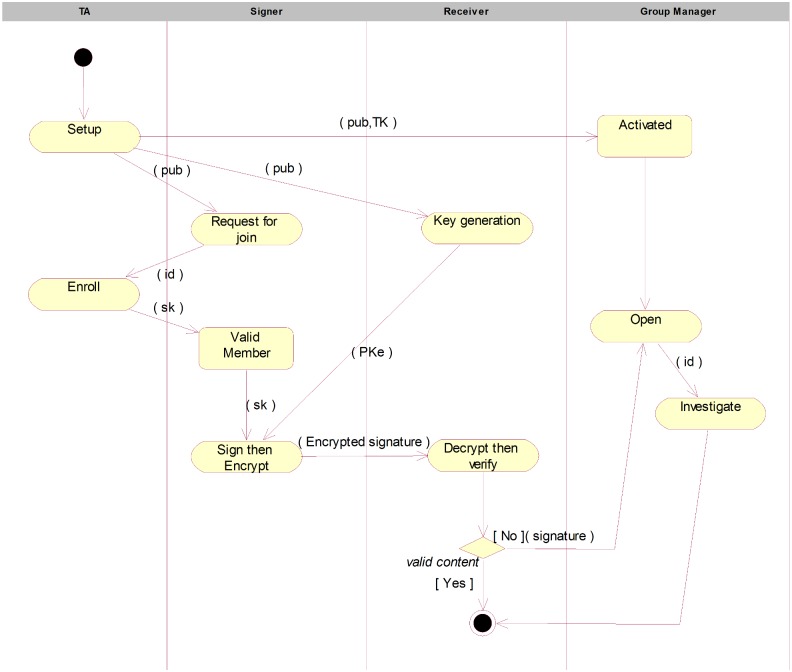
The activity diagram.